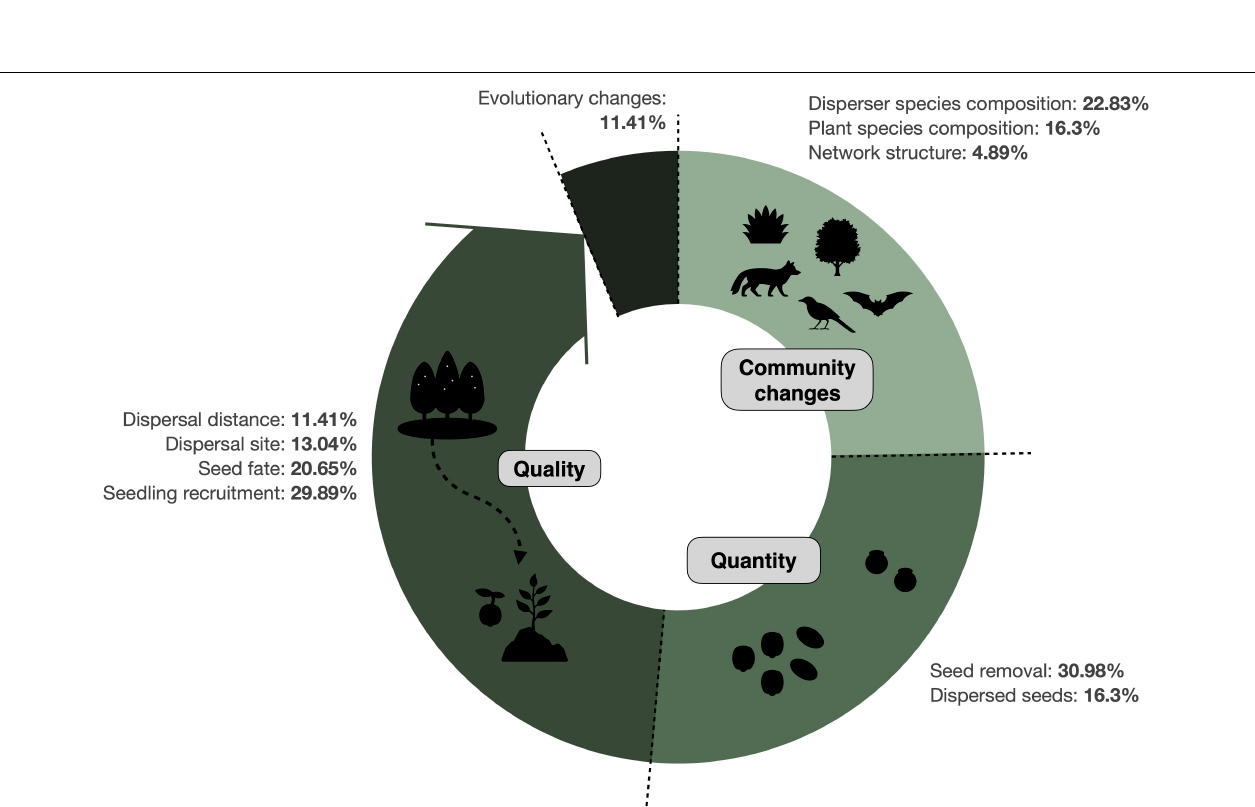
FIGURE 3 | Ecosystems and dispersers documented in SDD studies. Shown are the percentage of studies reporting SDD (A) in each type of ecosystem ( N = 196 records) and (B) for each seed disperser functional group ( N = 237 records). Note that the scale of the x-axes differs between (A , B) .